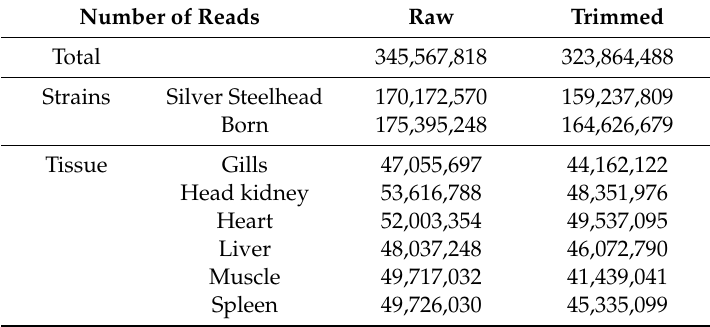
Table 1. Total number of sequencing reads obtained per strain and tissue. Number of Reads Raw